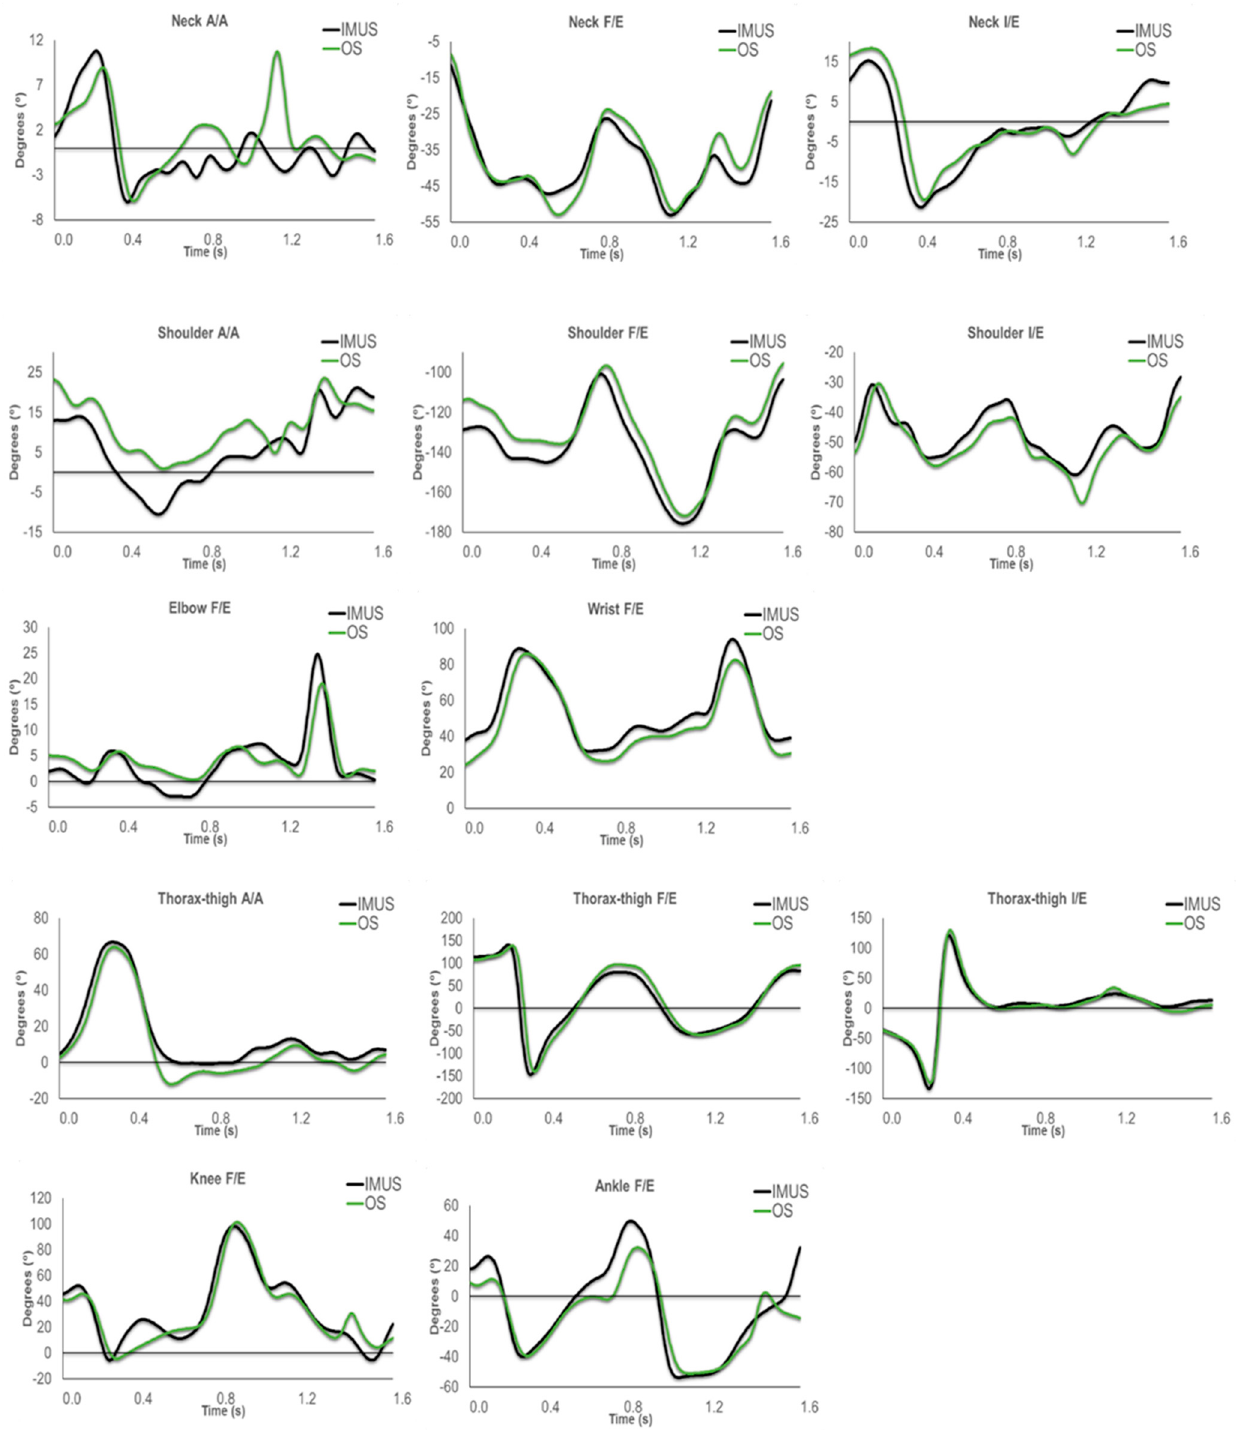
Figure 2. Joint angles curves from IMUS and OS for a trial of one participant performing the round-off back handspring. Note: A/A = abduction/adduction; F/E = flexion/extension; I/E = internal/external rotation.